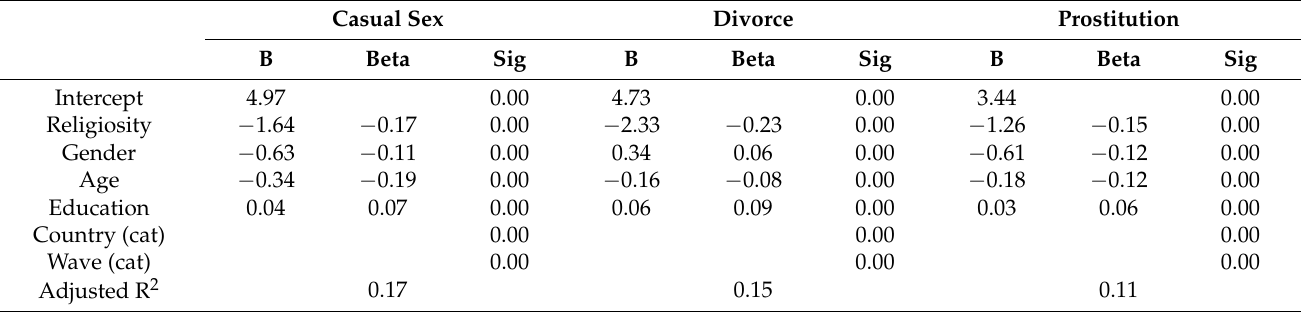
Table 2. OLS regression on Casual sex, Divorce and Prostitution. All countries included. A more detailed table is available in the Supplementary